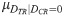
Scatter plots of simple and conditional trait differences as functions of the background effect.100 simulated mean differences DTR (in Black) and conditional mean difference μDTR|DCR=0 (in Red) versus the background effect DCR in the unit of σDCR and 95% prediction ellipses for each setting of σg2:σe2=(0,0.1,1,5).